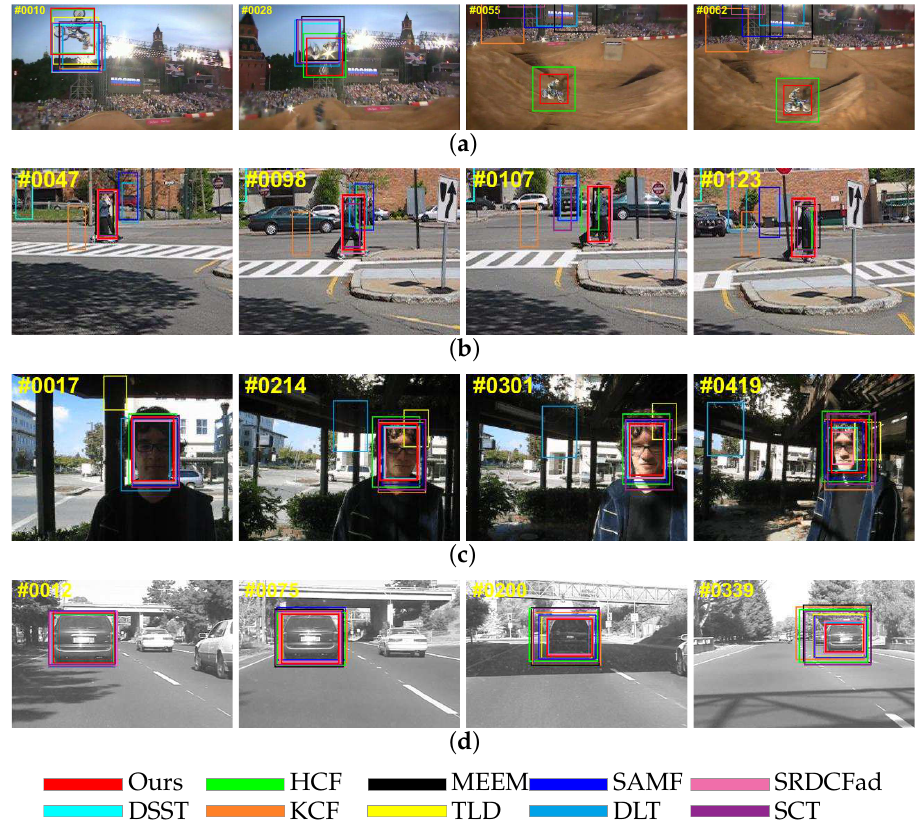
Figure 7. Tracking results on sequences with attributes of occlusion and background cluster. From top to bottom, the name of the video is ( a ) MotorRolling; ( b ) Couple; ( c ) Trellis; ( d )